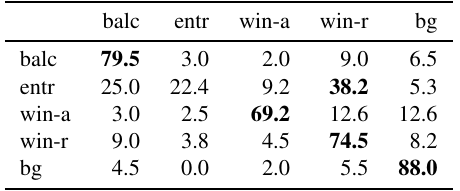
Table 3: Confusion matrix just using aggregates of A 4 , accuracy